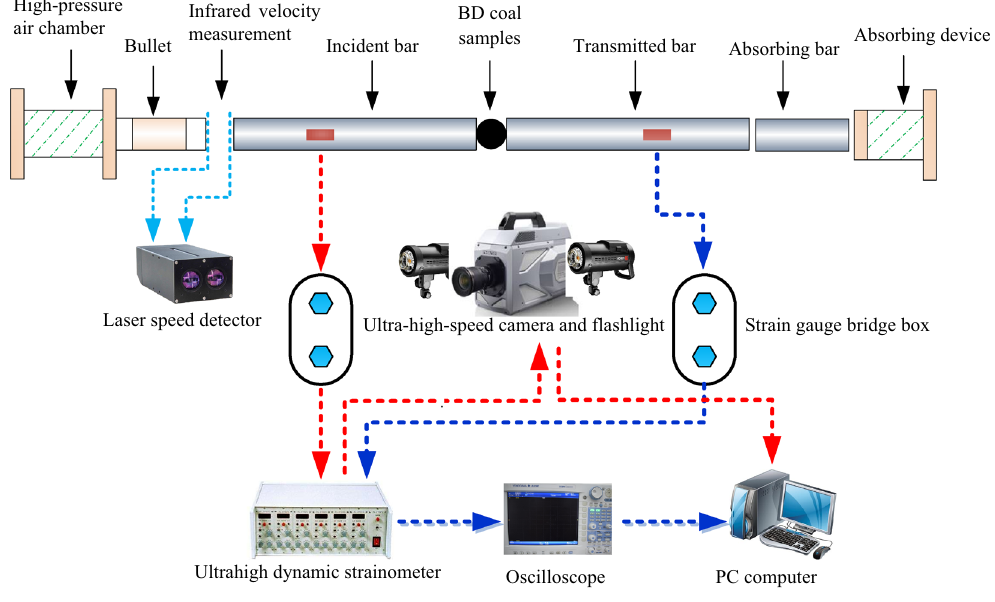
Figure 2. SHPB and high-speed DIC test